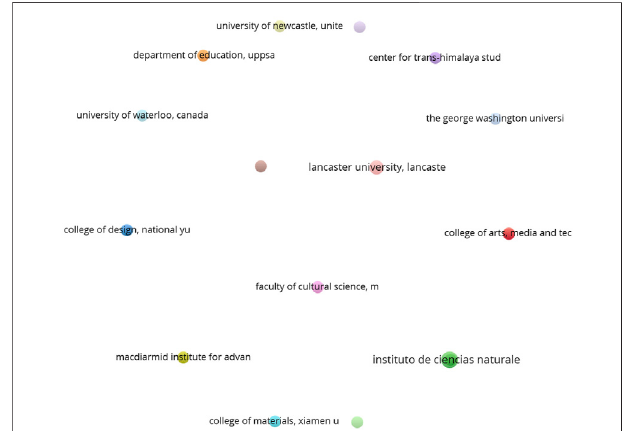
FIGURE 5 | Global cooperation networks of institutions working on sustainable crafts. Source: Authors ’